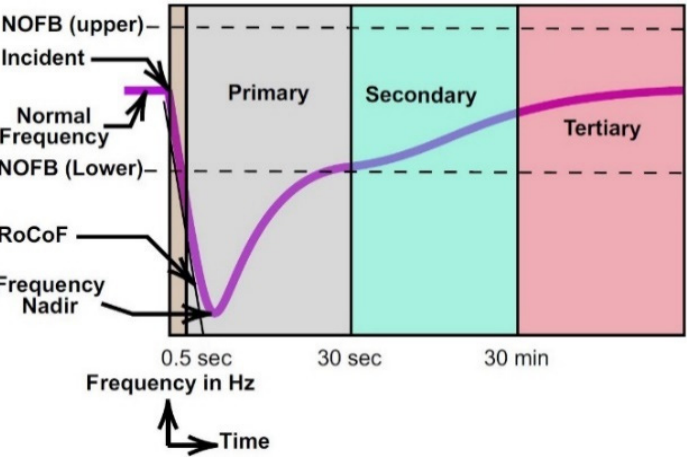
Figure 6. Frequency response of a power system under different control actions.